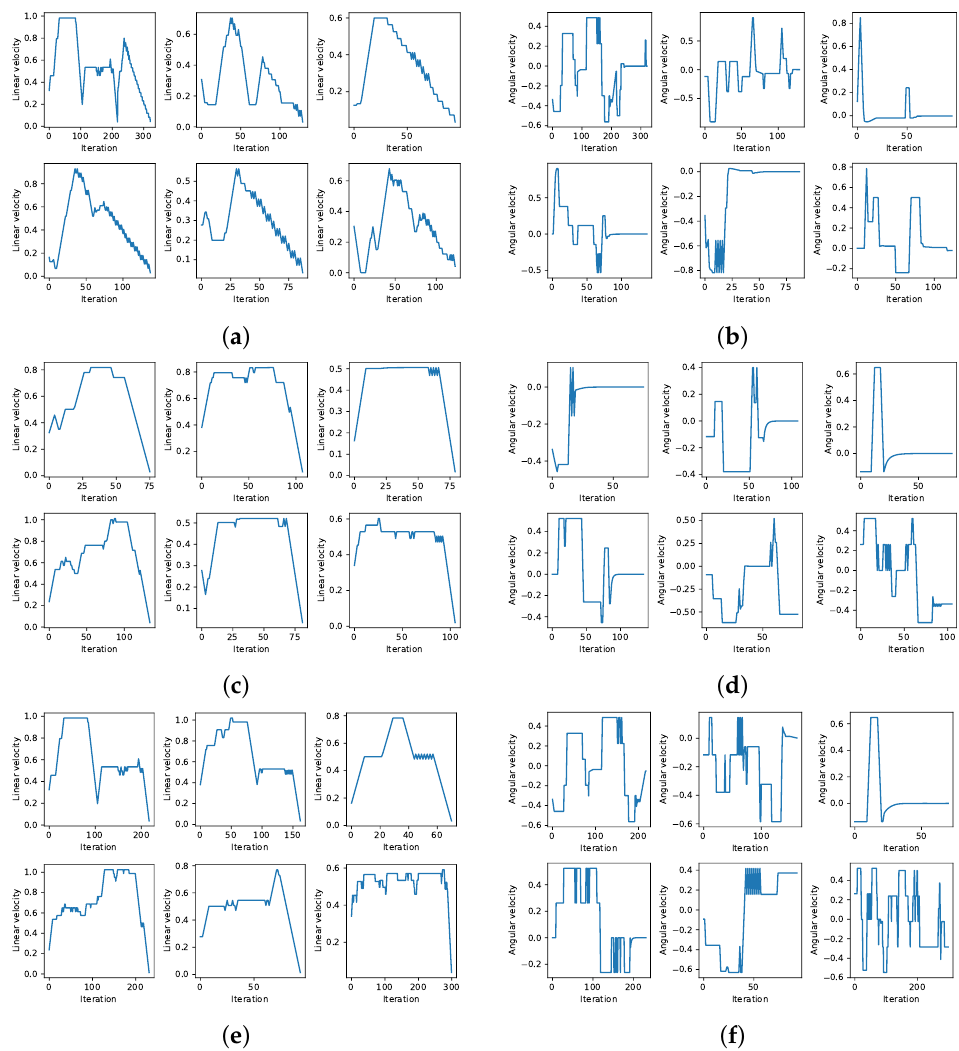
Figure 9. Velocity profiles for S-DOVS, RL-DOVS-A and RL-DOVS-D systems in six different sce- narios. ( a ) Linear velocity S-DOVS. ( b ) Angular velocity S-DOVS. ( c ) Linear velocity RL-DOVS-A. ( d ) Angular velocity RL-DOVS-A. ( e ) Linear velocity RL-DOVS-D. ( f ) Angular velocity